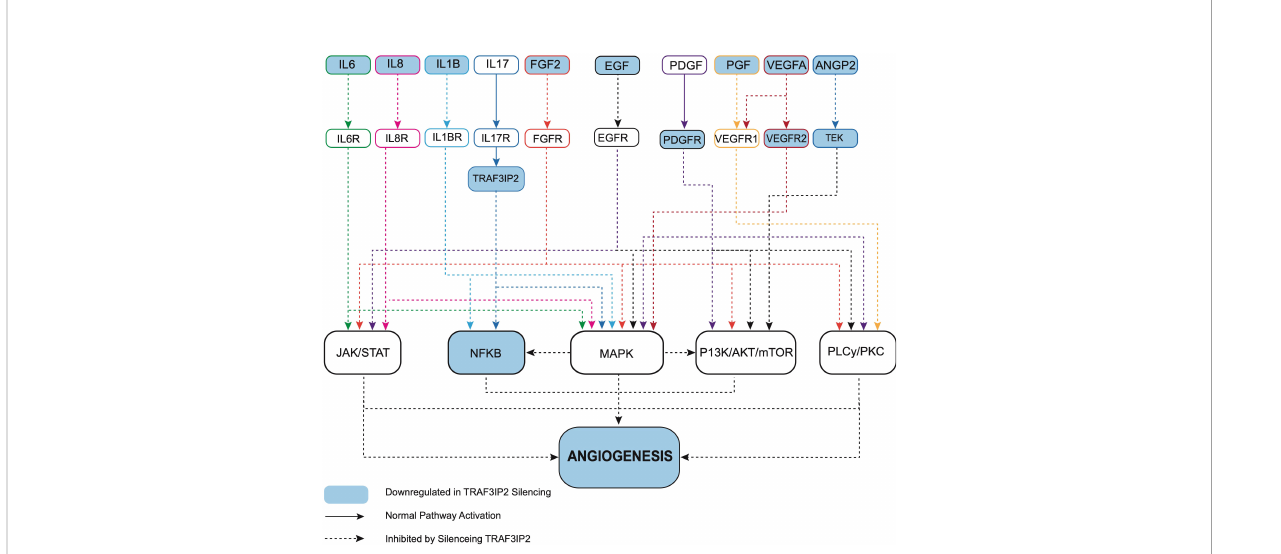
FIGURE 5 Ingenuity pathway analysis (IPA) reveals that targeting TRAF3IP2 coordinately inhibits multiple pro-angiogenic pathways. IPA reveals that targeting TRAF3IP2 coordinately inhibits multiple pro-angiogenic pathways. Gene expression analysis revealed a differentially expressed gene list between the U87 TRAF3IP2KD and U87 control shRNA cells. IPA ® canonical pathway analysis and molecular network analysis revealed HIF-1 a signaling, tumor microenvironment signaling, and neuroin fl ammation pathways as top regulated pathways.